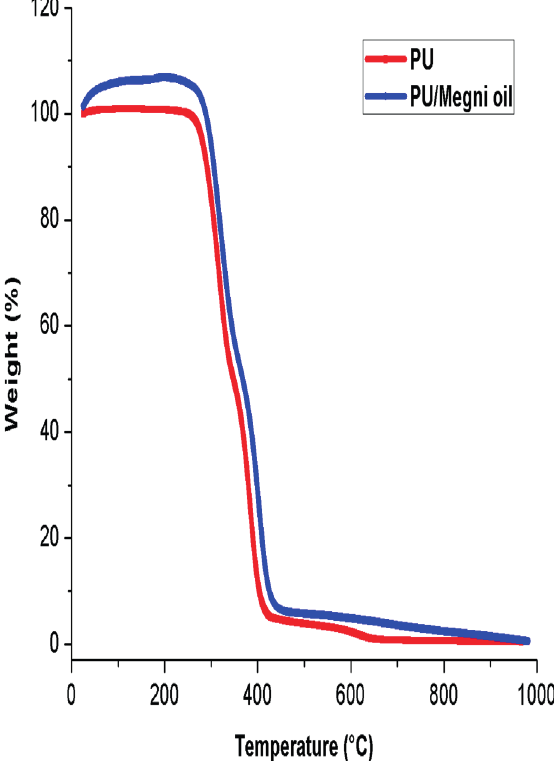
Figure 3 - TGA analysis of PU membrane and PU/Megni oil